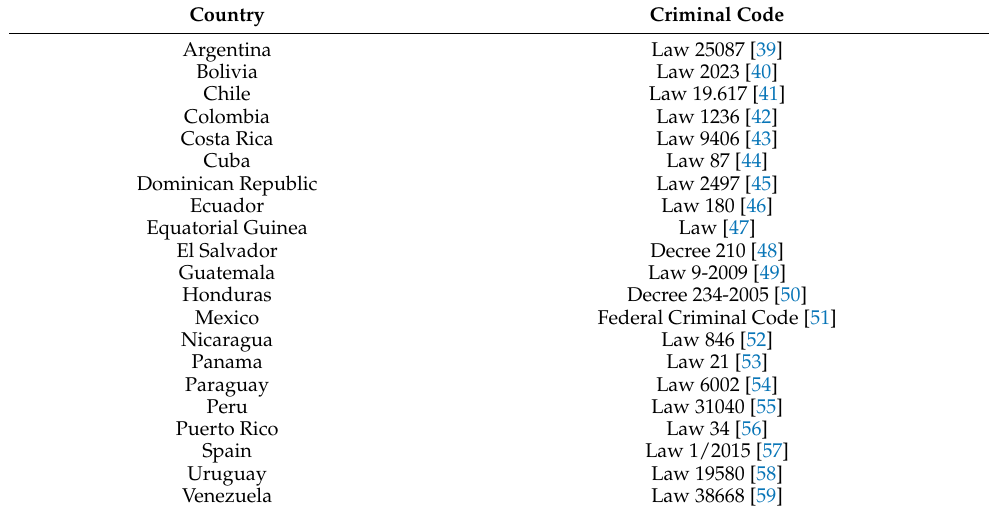
Table 1. Laws that have modified sexual crimes in the Criminal Codes of Spanish-speaking